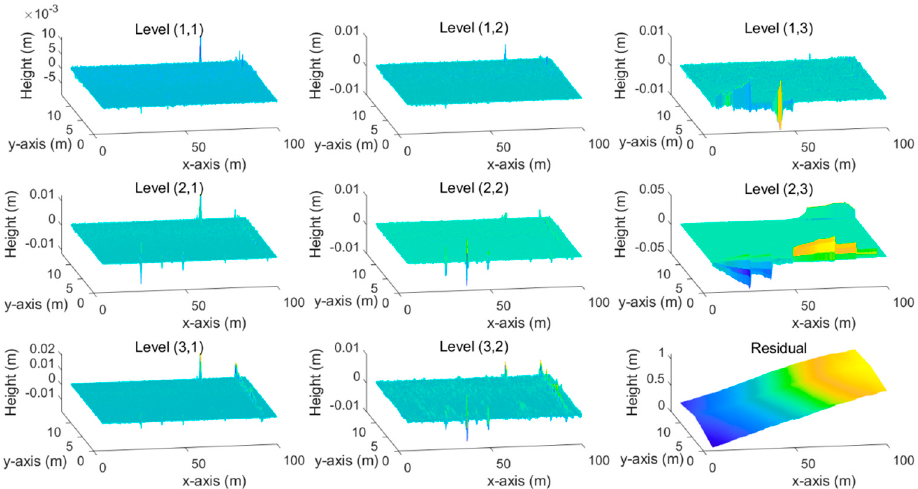
Figure 5. Wavelet decomposition results.